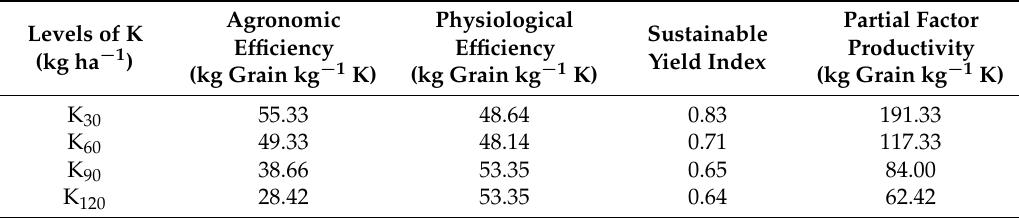
Table 5. Potassium use efficiency, sustainable yield index, and partial factor productivity of hybrid rice as influenced by potassium fertilization (means for 2016 and 2017). (Table 4), with significant ( p ≤ 0.05) variation over control. Agronomic efficiency and physiological